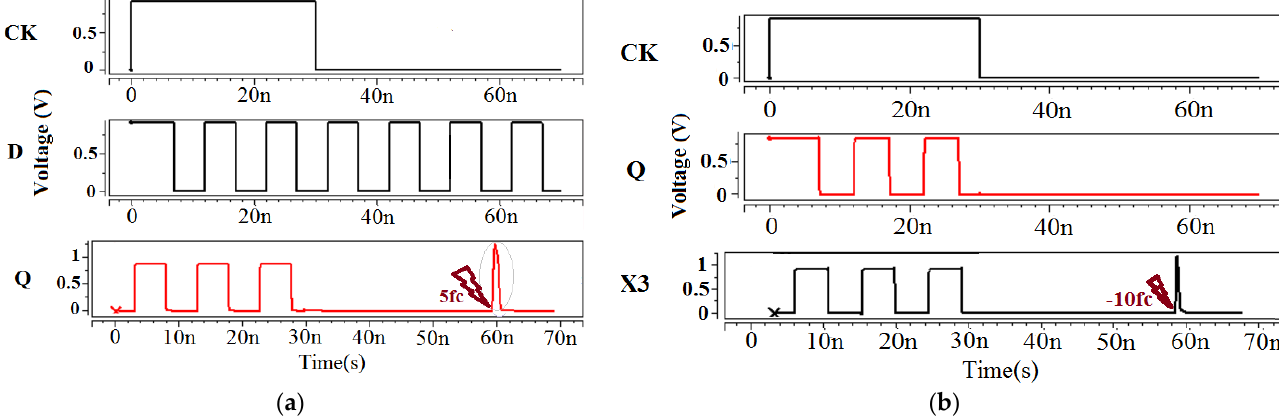
( b ) Figure 5. Test results when the output is “0” during the holding time: ( a ) negative and positive SEU injection to “X1” and “X2” nodes, respectively; ( b ) positive SEU injection to “X4” and “X5” nodes, respectively.